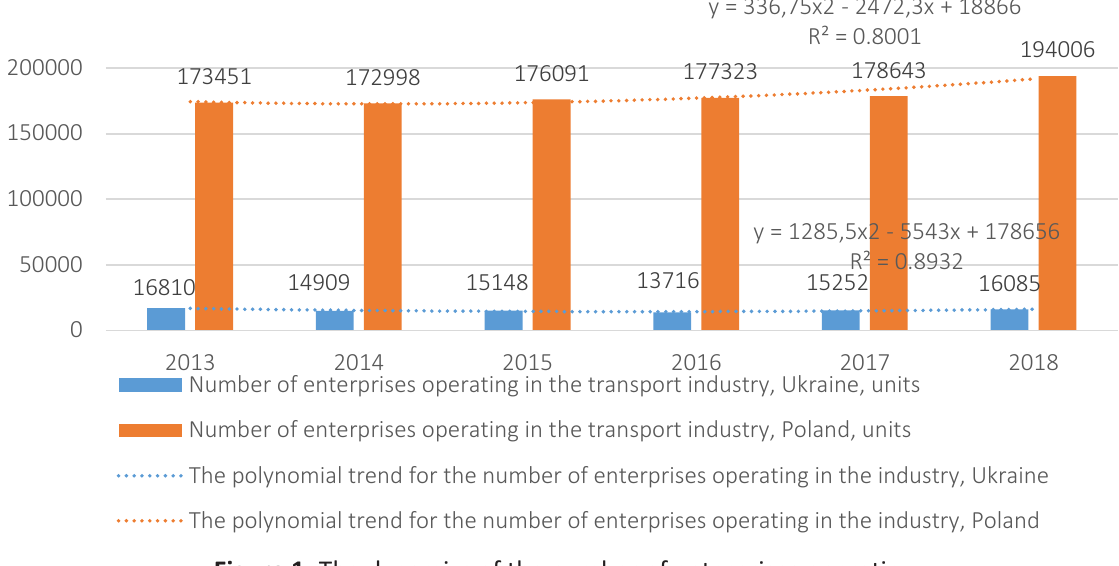
Figure 1. The dynamics of the number of enterprises